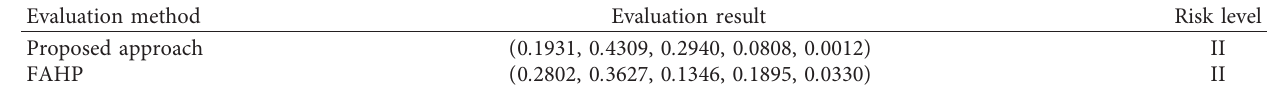
Table 7: The comparison results of the proposed approach and